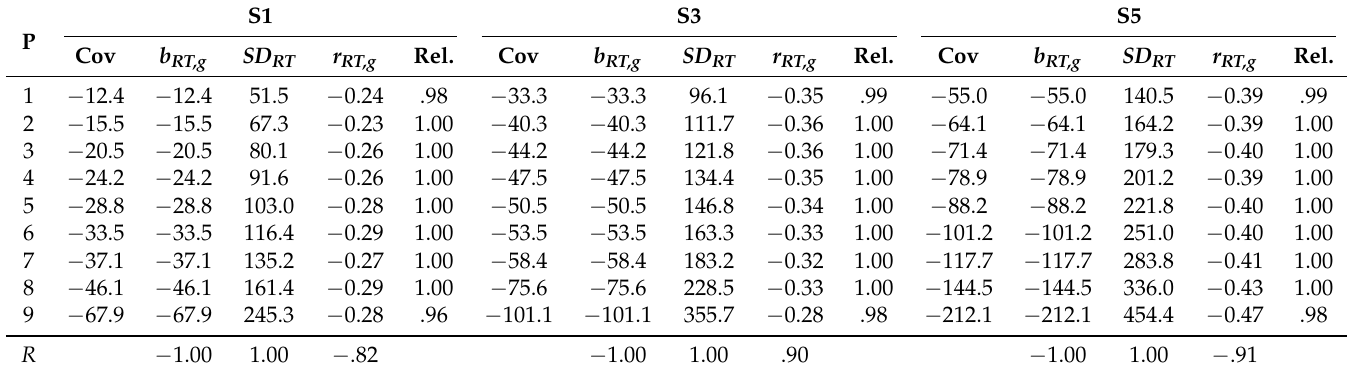
Table 7. Covariance, unstandardized regression weight, standard of RT, correlation, and reliability of RTs across the nine RT bands in all three experimental